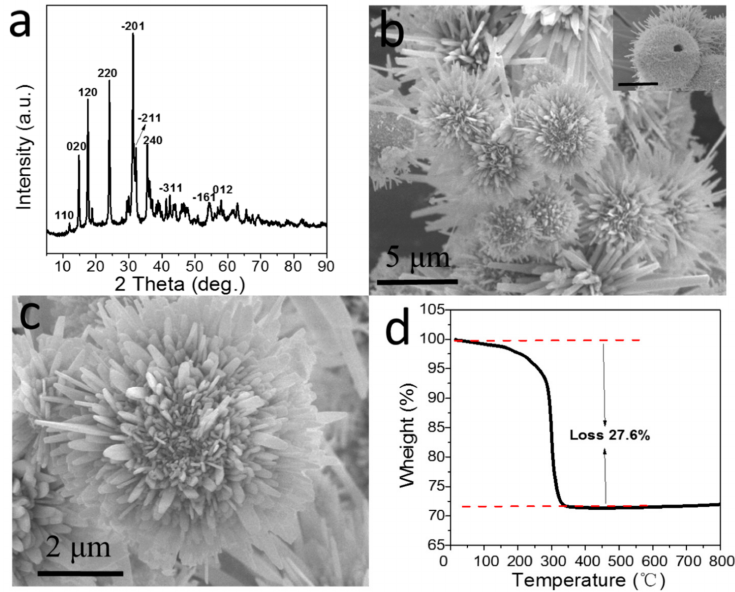
Figure 1. ( a ) X-Ray Diffraction (XRD) pattern; ( b , c ) Scanning Electron Microscopy (SEM) images; and ( d ) Thermal Gravimetric (TG) curve of the precursor of H-SnO 2 -CuO before calcination. The inset of panel ( b ) shows the hollow interior, bar, 2 µ